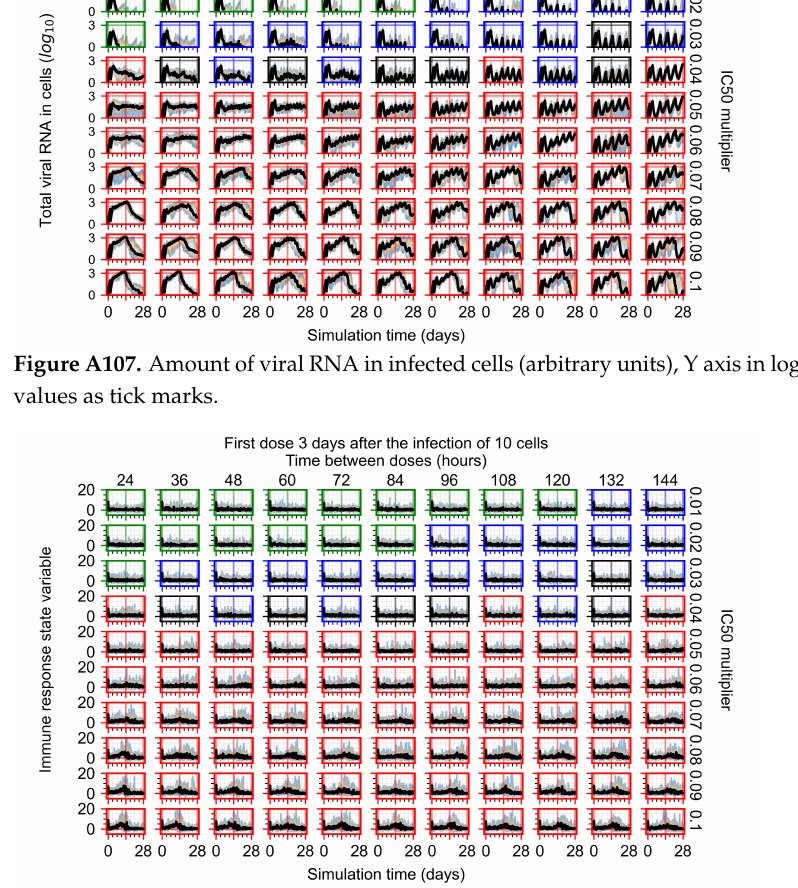
Figure A108. Immune response state variable number. Positive values correspond to an inflammatory state, and negative to an anti-inflammatory state.